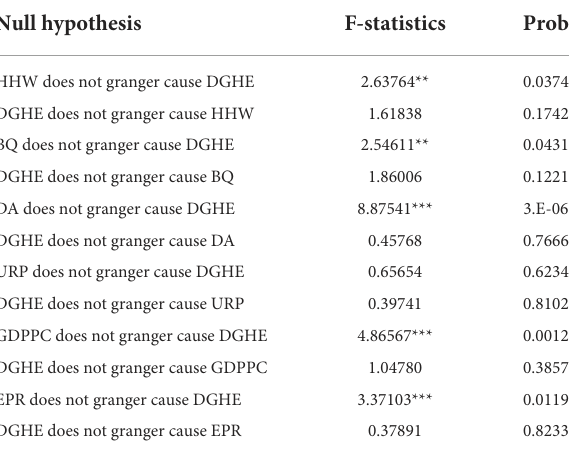
TABLE 10 Causality